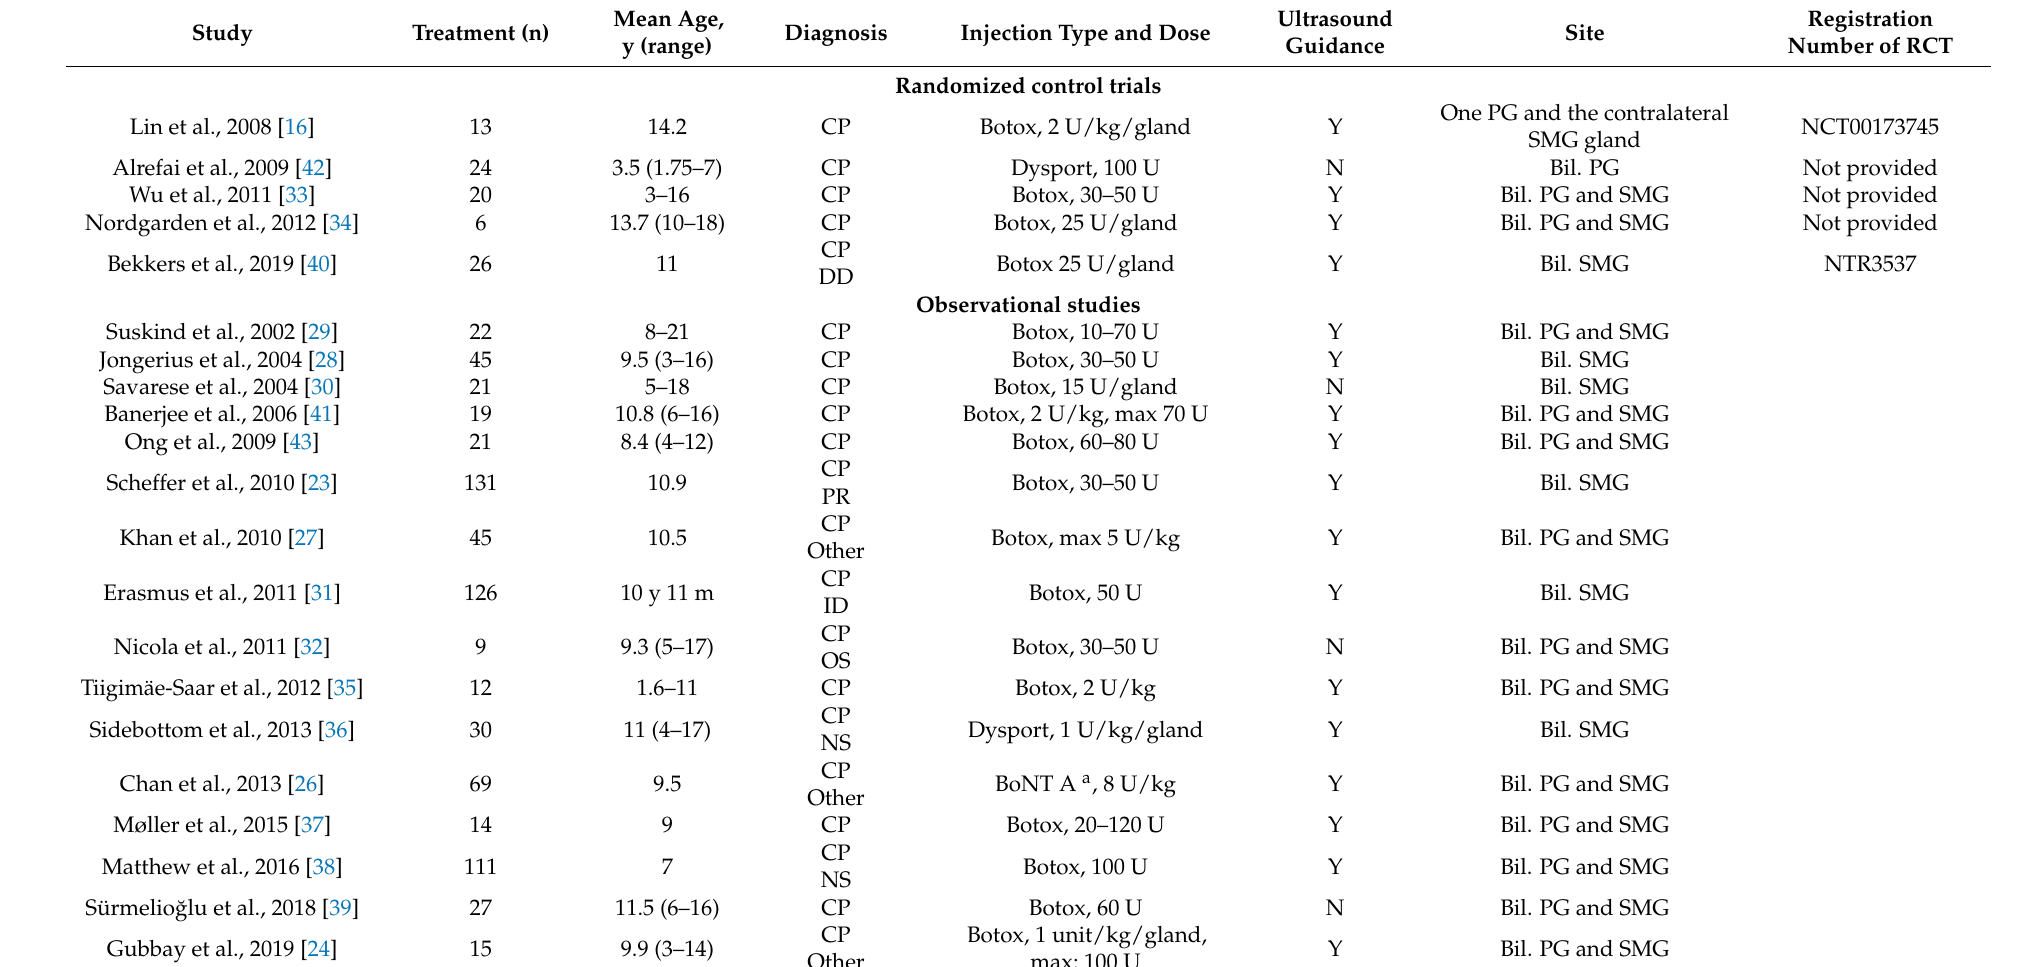
Table 1. Population characteristics of included